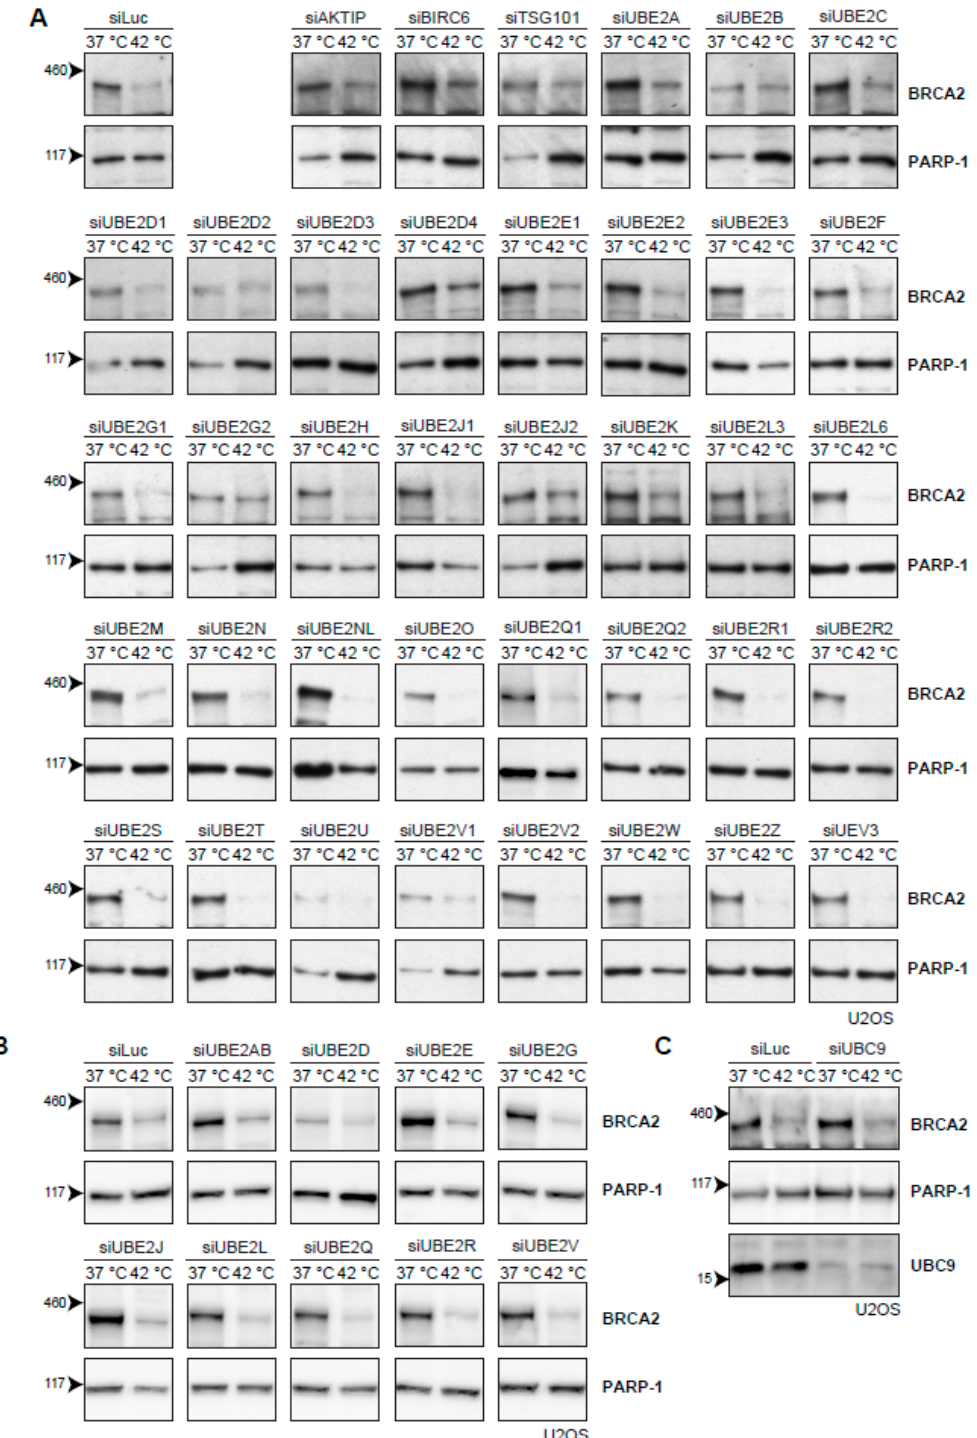
Figure 4. E ff orts to identify the E2-conjugating enzyme that mediates degradation of BRCA2 upon hyperthermia. ( A ) Results of individual knock-down of all known ubiquitin E2-conjugating enzymes in U2OS cells. E ffi ciencies of E2 siRNAs were previously assessed by quantitative polymerase chain reaction PCR [37]. ( B ) Results of simultaneous knock-downs of E2-conjugating enzymes belonging to specific families in U2OS cells. ( C ) Results of knock-down of the small ubiquitin-like modifier (SUMO)-E2 enzyme Ubiquitin Conjugating Enzyme 9 (UBC9) in U2OS